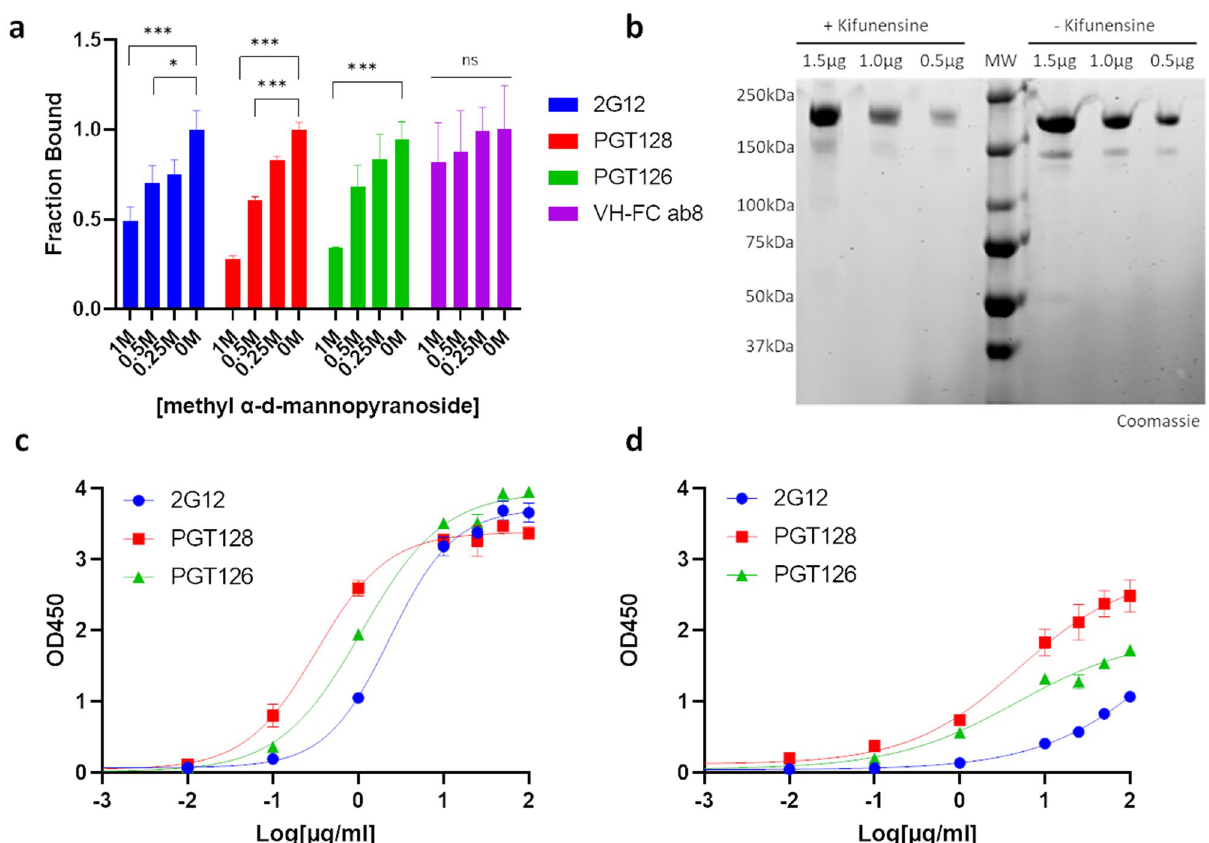
Figure 4. 2G12, PGT128 and PGT126 cross-react with the SARS-CoV-2 Spike in a glycan dependent manner. ( a ) SARS-CoV-2 S ectodomain binding by anti-gp120 antibodies in the presence of methyl α-d- mannopyranoside. Plates were coated with SARS-CoV-2 S ectodomain and incubated with dilutions of methyl α-d-mannopyranoside along with a constant amount of the indicated antibodies. Antibody binding was quantified via ELISA. ( b ) SDS-PAGE analysis of varying amounts of purified SARS-CoV-2 S ectodomain expressed in cells either in the presence or absence of kifunensine. (MW: molecular weight ladder). See Fig. S6 in supplementary information for uncropped gel images. ( c–d ) ELISA analysis of anti-gp120 antibody interactions with SARS-CoV-2 S ectodomain expressed in cells either in the presence ( c ) or absence of kifunensine ( d ). Experiments were done in triplicate; error bars indicate standard deviation (n = 3). Statistical significance was tested by two-way ANOVA with Dunnett post-test ( P > 0.05 [ns, not significant], * P ≤ 0.05, ** P ≤ 0.01, *** P ≤ gp120 Monoclonal (35O22), from Drs. Jinghe Huang and Mark Connors, Anti-HIV-1 gp120 Monoclonal (10- 1075) from Dr. Michel C. Nussenzweig (cat# 12,477), Anti-HIV-1 gp120 Monoclonal (VRC01), from Dr. John Mascola (cat# 12,033), Anti-HIV-1 gp120 Monoclonal (VRC03), from Dr. John Mascola (cat# 12,032). VH-Fc ab8 was a gift from Dr. Dimiter S. Dimitrov. Protein expression and purification. Transfections were performed as previously described 30,31 , with modifications. To express the SARS-CoV-2 2P S ectodomain, Expi293 cells were transfected at a density of 3 × 10 6 cells/ml using linear polyethylenimine (PEI) (Polysciences). For Kifunensine treatment, cultures were treated with 5 μM Kifunensine 3 h post-transfection. At 24 h post-transfection, cultures were supplemented with 2.2 mM valproic acid. The supernatant was harvested by centrifugation after 5 days, filtered and loaded onto a 5 mL HisTrap Excel column (Cytiva). The column was washed with buffer (20 mM Tris pH 8.0, 500 mM NaCl, 20 mM imidazole) and the protein was eluted with buffer (20 mM Tris pH 8.0, 500 mM NaCl, 500 mM imidazole). Purified protein was concentrated and loaded onto a Superose 6 column (Cytiva) equilibrated with GF buffer (20 mM Tris pH 8.0 and 150 mM NaCl). Peak fractions were pooled, concentrated and flash frozen. Enzyme‑linked immunosorbent assay (ELISA). 100 µl of SARS-CoV-2 2P S protein preparations were coated onto 96-well MaxiSorp plates at 1 µg/ml in PBS overnight at 4 °C. All washing steps were performed 5 times with PBS + 0.05% Tween 20 (PBS-T). After washing, wells were either incubated with BSA-based block- based blocking buffer or Casein-based blocking buffer for 2 h at room temperature. After washing, wells were